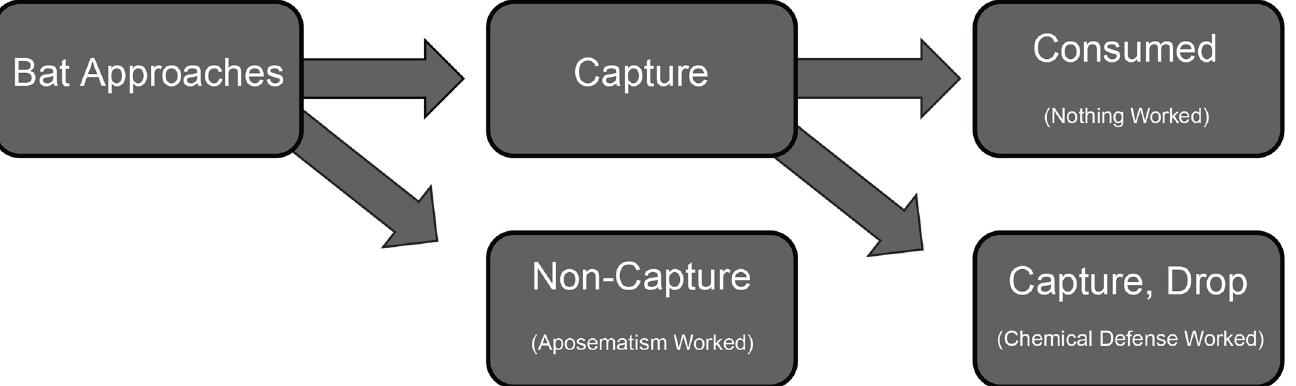
Fig 8. Ethogram showing the progression of bat attacks and possible outcomes of bat-moth interactions. A bat approaches a moth and can either capture or not capture that moth. If the moth is not captured that encounter has ended and the moth has survived. If the bat has captured a moth it can then either drop it or consume it. In this study ’ s context, if a sound-producing moth is not captured it is evidence that aposematism was effective in deterring the bat attack. If a captured moth is rejected by being dropped they typically survive and this is evidence that defensive chemistry was effective in deterring